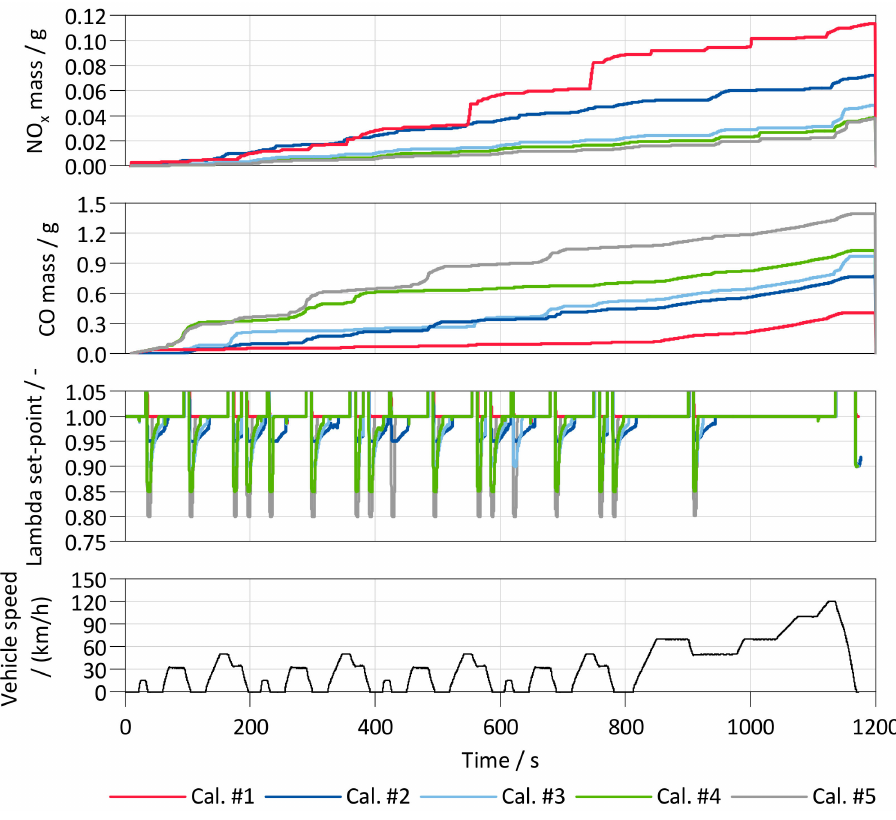
Figure 16. Impact of different calibration strategies for catalyst purging on a HiL test